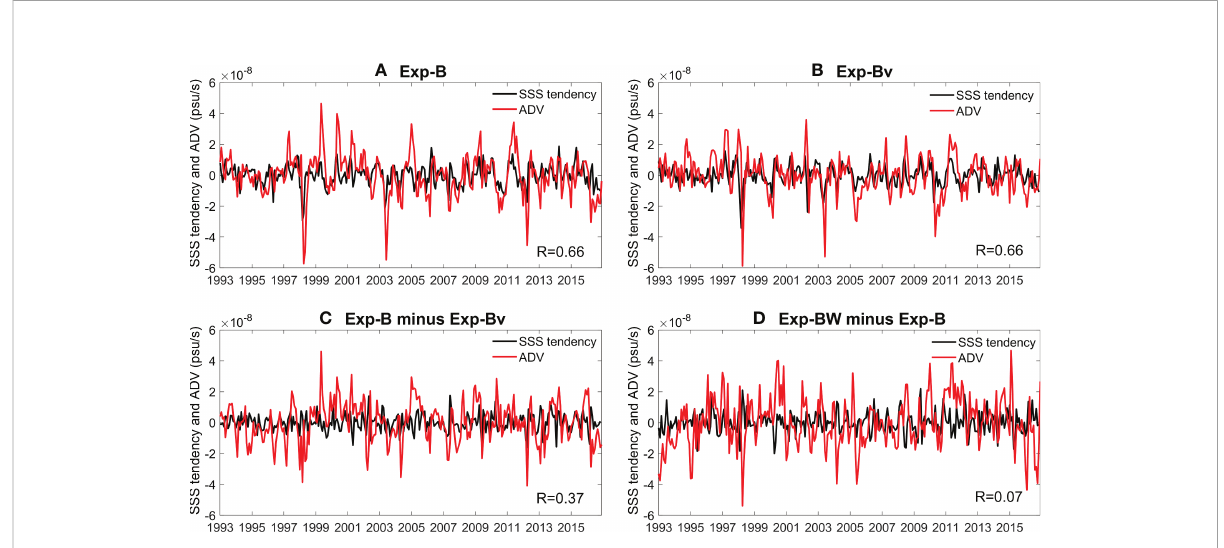
FIGURE 15 Time series of monthly SSS tendency (black; in psu/s) and ADV (red; in psu/s) averaged over the SEIO derived from (A) Exp-B, (B) Exp-Bv, (C) Exp-B minus Exp-Bv and (D) Exp-BW minus